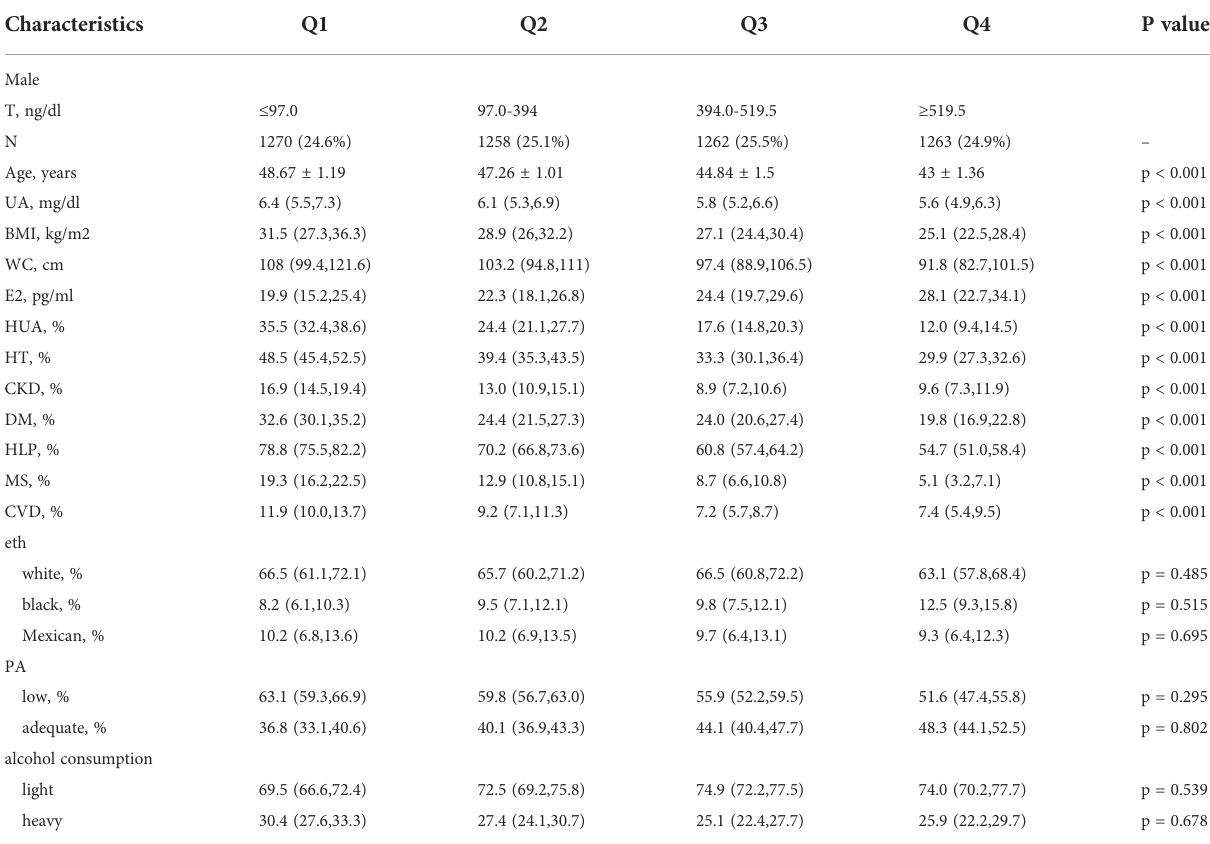
TABLE 2 General characteristics of male participants by T